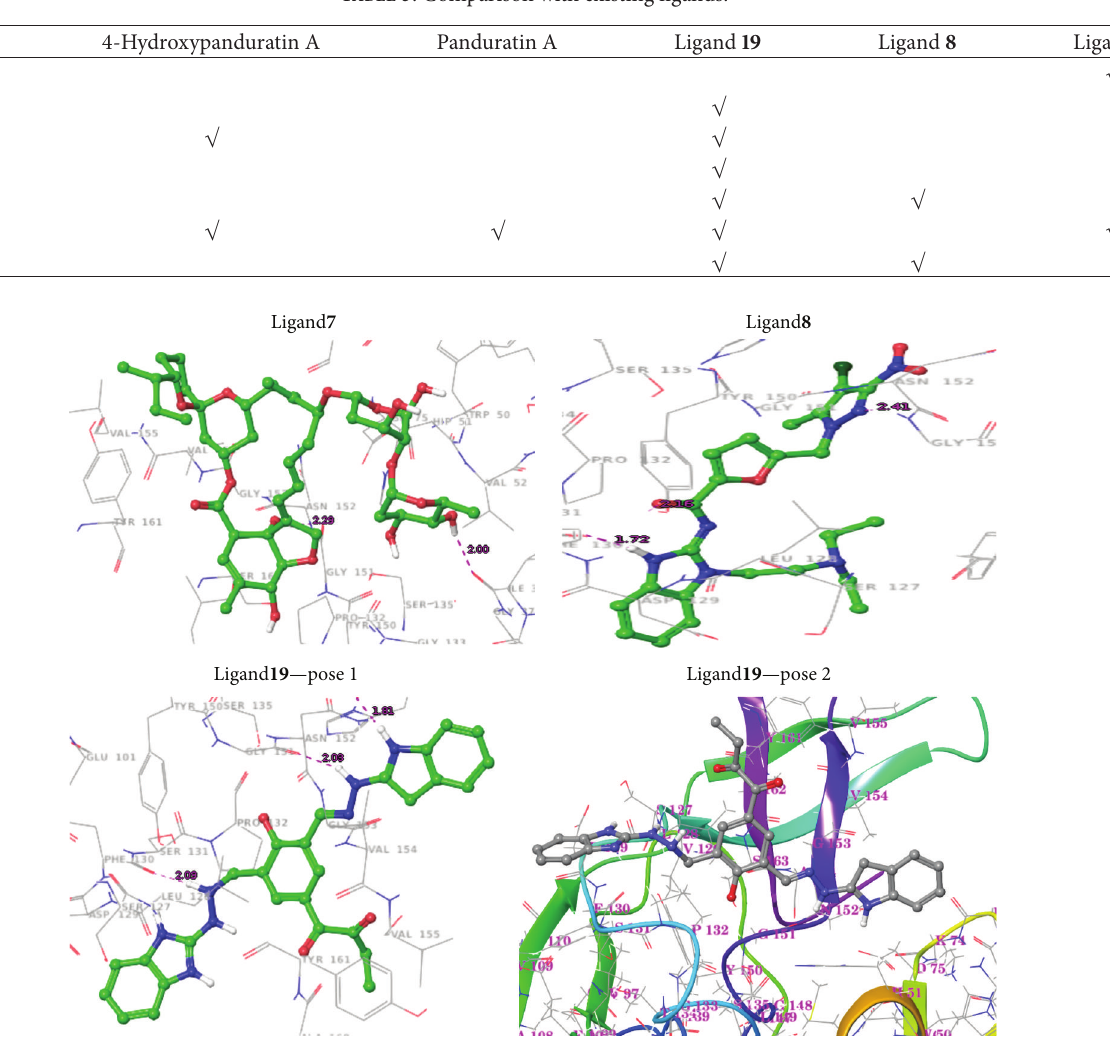
Table 5: Comparison with existing ligands.